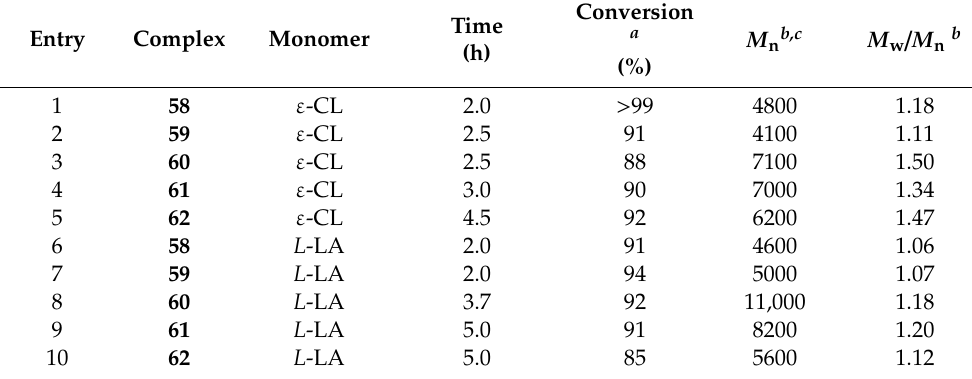
Figure 14. Dinuclear titanium complexes supported by substituted diphenolate ligands [28]. Table 16. ROP of ε -CL and L -LA catalyzed by bimetallic titanium complexes 58–62 [28].